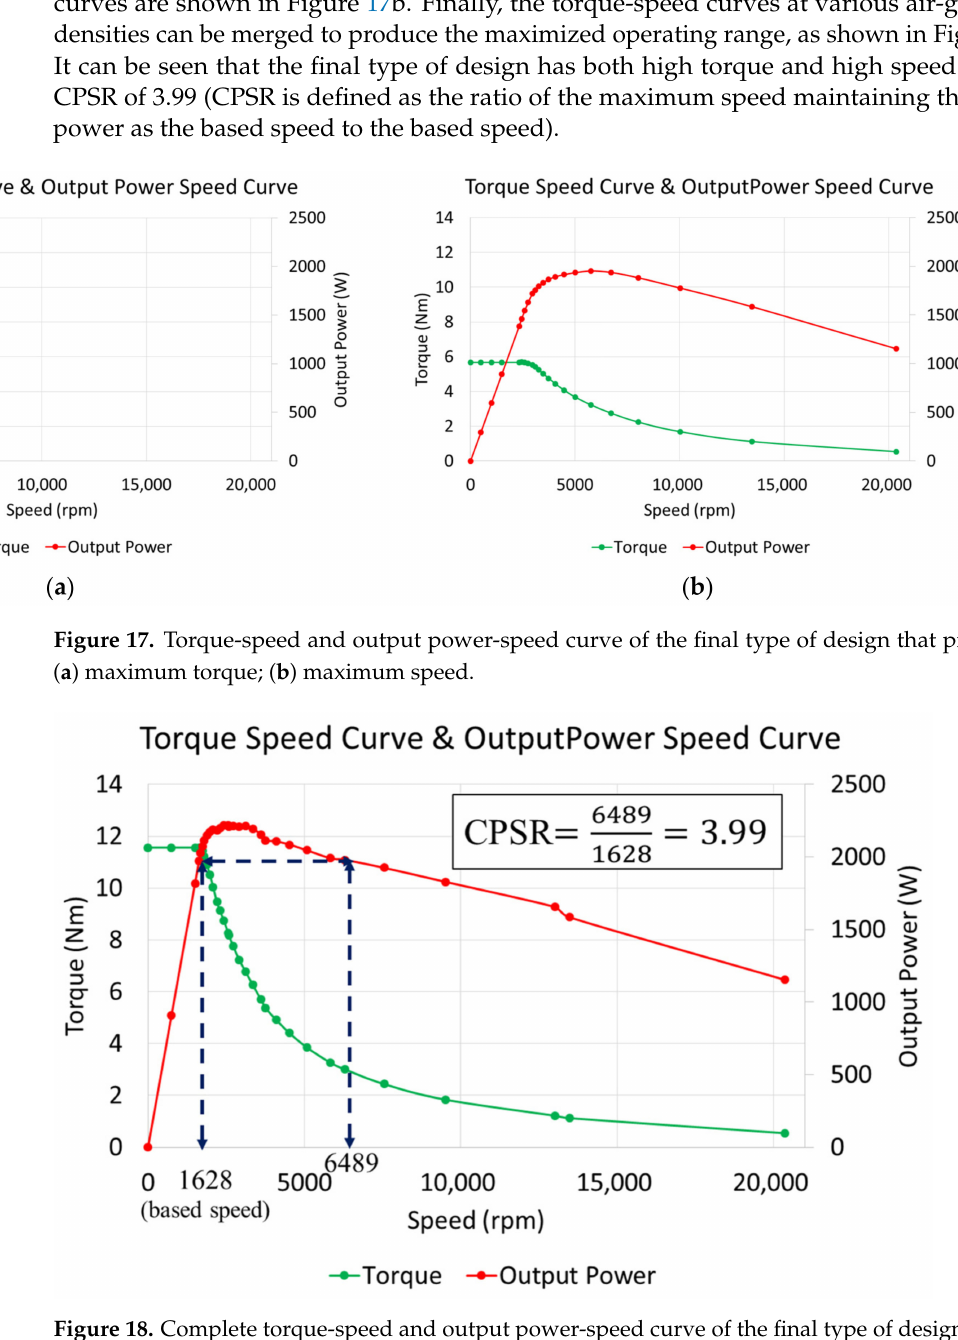
Figure 18. Complete torque-speed and output power-speed curve of the final type of